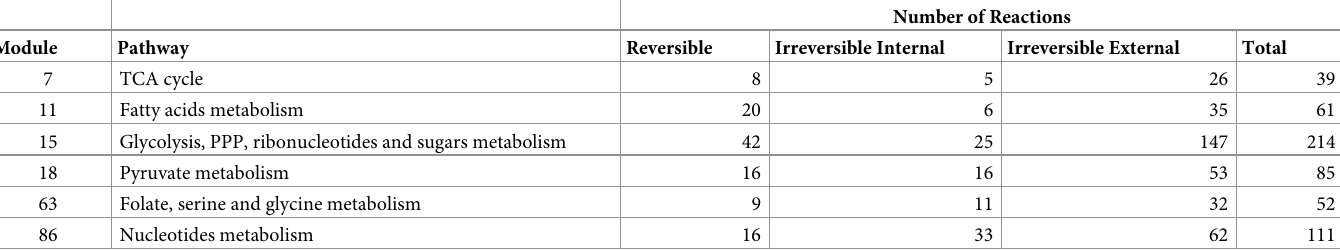
Table 1. Topologically independent modules of iJO1366 . The 294 structural reversible reactions were grouped in 103 modules (see Table C in S1 Table for the full list of modules). Here features of the six largest modules are presented.